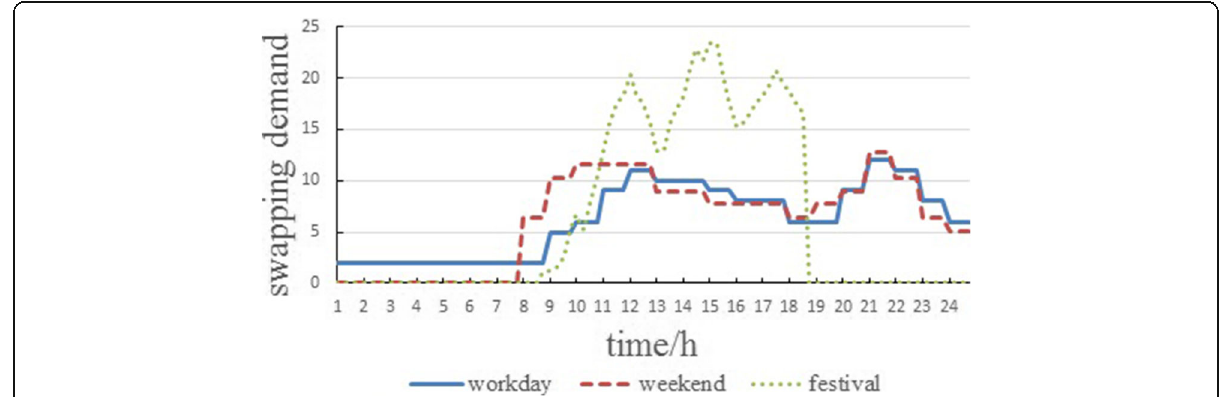
Fig. 3 Typical battery swapping demand curves on workdays, weekends and in festival